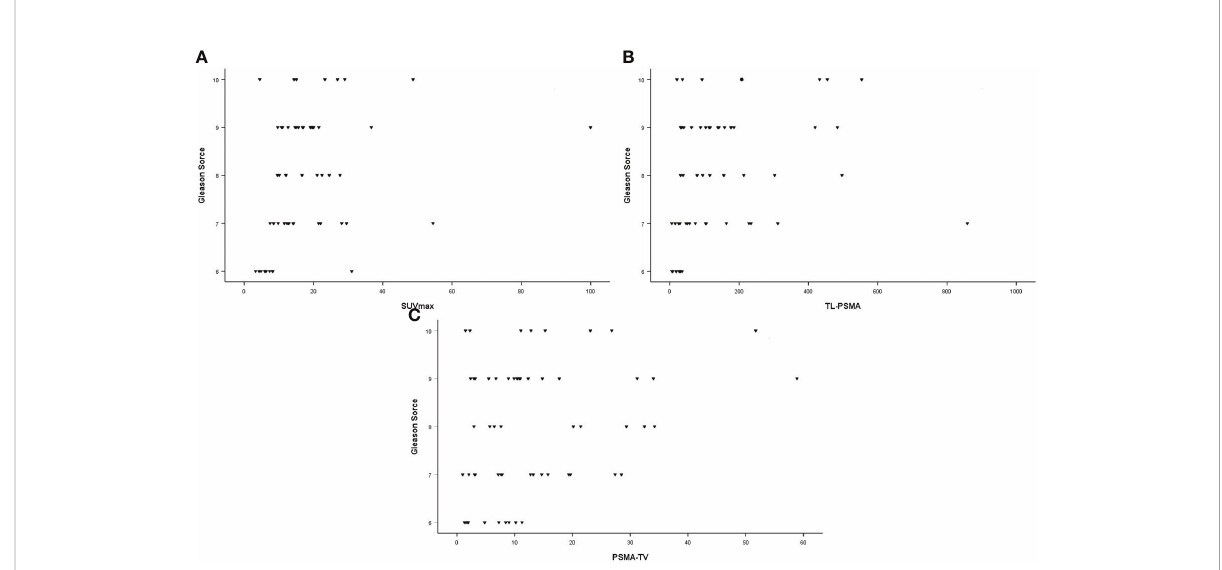
FIGURE 3 Correlation between Gleason scores and primary tumor prostate-speci fi c membrane antigen (PSMA) PET parameters. (A) Maximum standardized uptake value (SUVmax; r = 0.457; p < 0.001). (B) Prostate total lesion PSMA (TL-PSMAp [cm 3 ]; r = 0.448; p < 0.001). (C) Prostate PSMA-tumor volume (PSMA-TVp [cm 3 ]; r =0.285; p = 0.027).